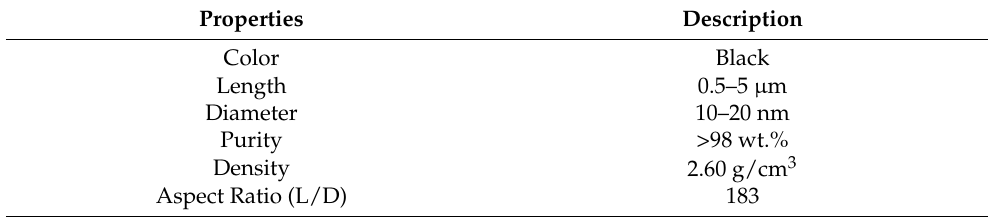
Table 2. Physical and mechanical properties of functionalized